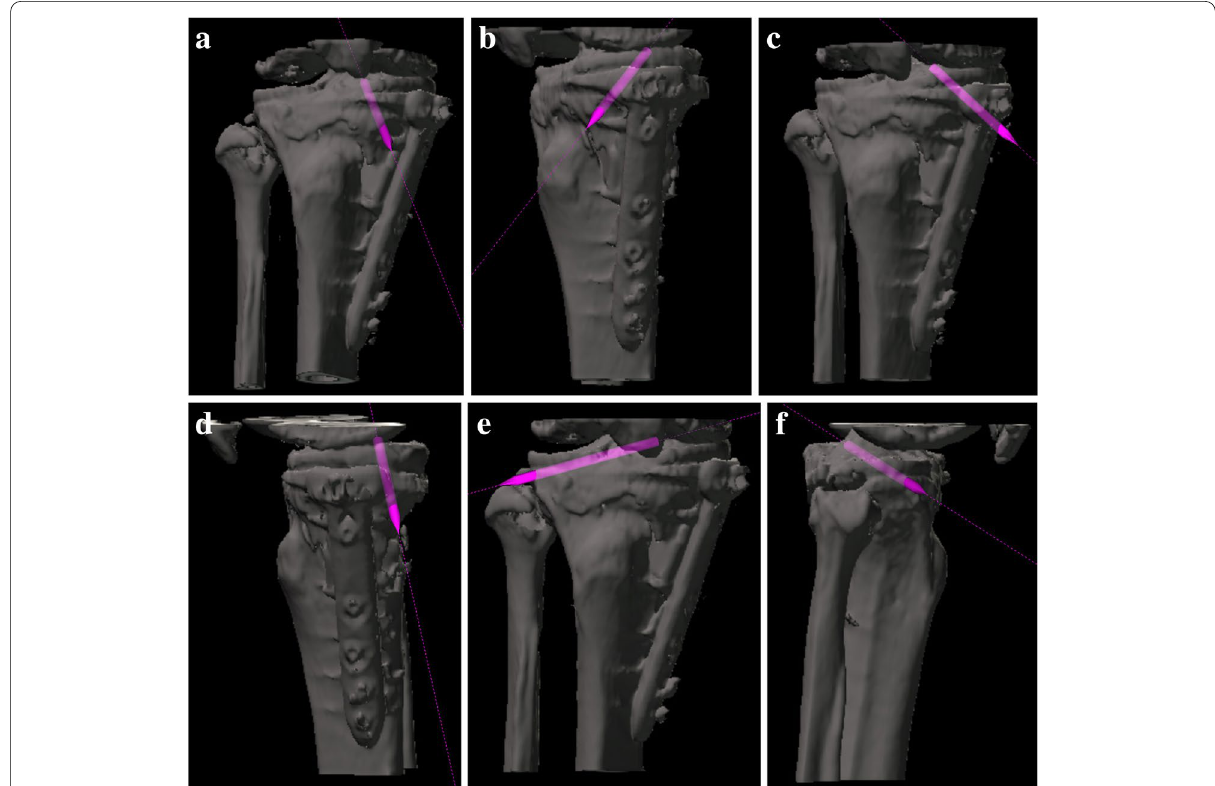
Fig. 2 Another aperture of the tibial tunnel was made on the anteromedial tibial cortex positioned anterior to the locking plate ( a , b ), posteromedial tibial cortex positioned posterior to the locking plate ( c , d ), and anterolateral tibial cortex in the proximal tibial fragment ( e , f ). In the anterolateral position, planes of transverse and ascending cuts were made, and a tibial tunnel was made to fit into the proximal tibial